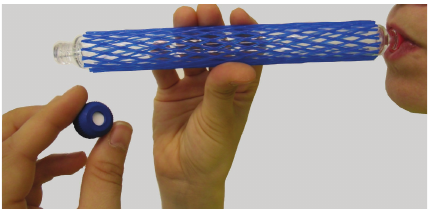
Figure 3: Sampling end-exhaled air with a gas sampling tube; mouthpiece screwed on; left hand: one of two sealing caps with septum; plastic net sleeve to protect glass.